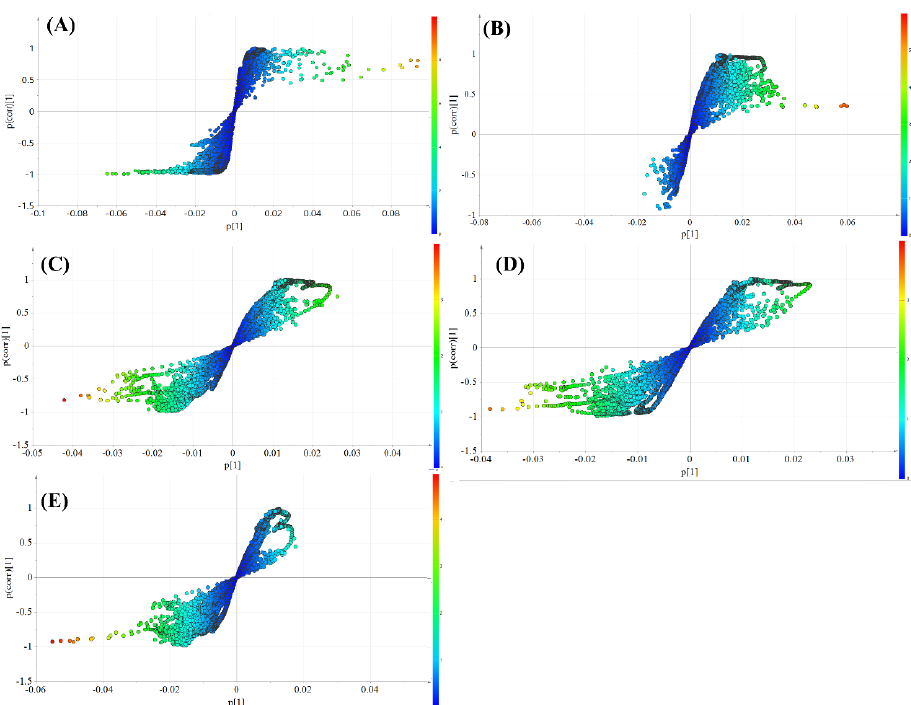
Figure 8. S-plot of different groups: ( A ) model group vs. normal group, ( B ) model group vs. polysaccharide knockout component of crude AB, ( C ) model group vs. polysaccharide knockout component of salt-processed AB, ( D ) model group vs polysaccharide component of crude AB, ( E ) model group vs. polysaccharide component of salt-processed AB. Table 4. Changes in relative levels of metabolites in the serum samples from different groups. AB-Treated sAB-Treated ABP-Treated sABP-Treated Group vs. Group vs. Group vs. Model Group vs. Model Group Model Group Group Model Group Metabolites δ( 1 H)